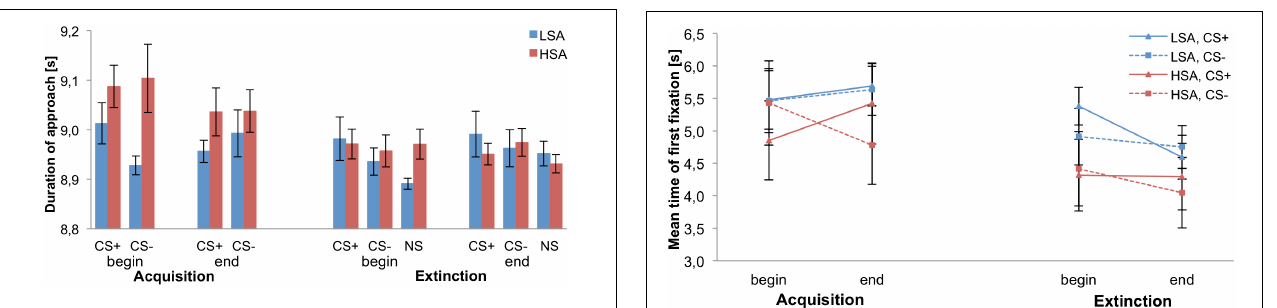
FIGURE 5 | Mean time of the first fixation within the social area of interest (agent) for low (LSA) and high socially anxious (HSA) participants ( n = 53). CS+ = agent paired with aversive unconditioned stimulus (US); CS − = agent without aversive US. Standard errors are presented by error